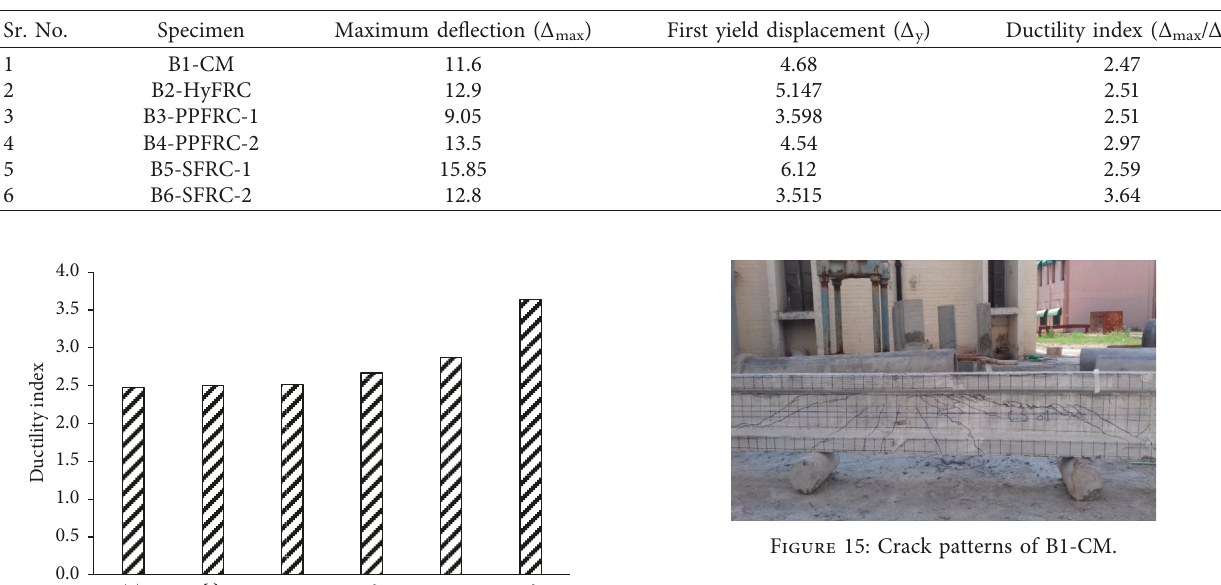
Table 4: Ductility index values of all girders.